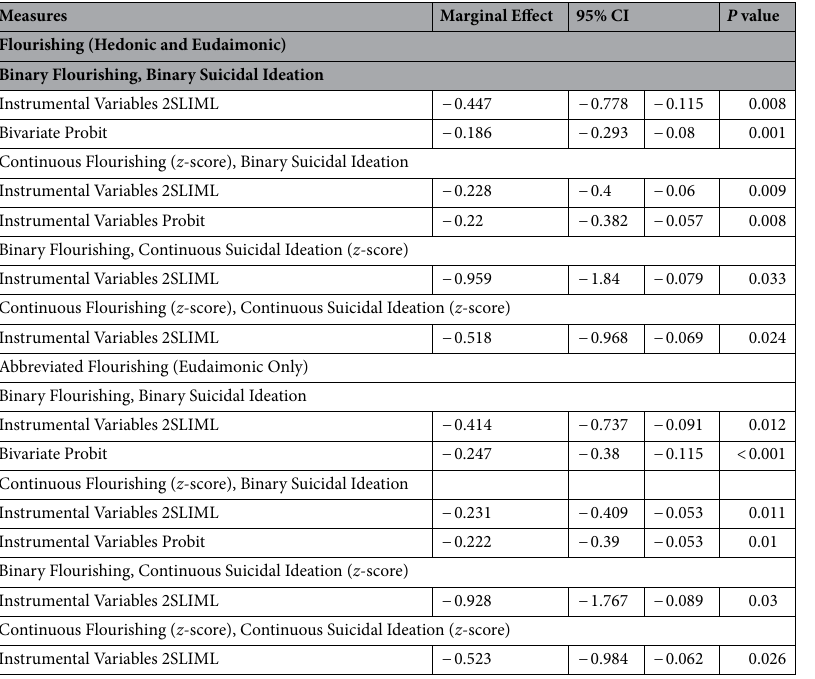
Table 3. Effect of Flourishing on Suicidal Ideation a . 2SLIML two-stage limited information maximum likelihood. a Controlled variables include age, sex, race/ethnicity, marital status, education, household income, health insurance, personality factors, substance use, binge drinking, health status, generalized anxiety, depression, severe psychological distress, 5 inflammatory markers, and chronic